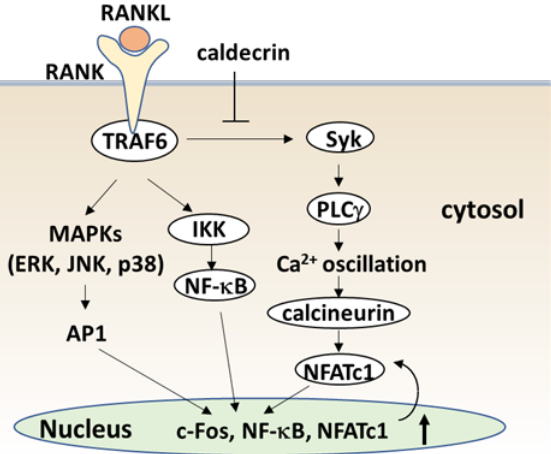
Figure 4. Caldecrin inhibits RANKL signaling in the initial stage of osteoclast differentiation. RANKL binding to RANK activates both NF - κB and MAPKs, such as ERK, JNK, and p38. Activation of NF- κB and MAPK signals is then transmitted to c -Fos and NFATc1 induction. Caldecrin inhibits RANK -stimulated phosphorylation of Syk and PLCγ , abolishing Ca 2+ oscillation and activation of calcineurin, and amplification of NFATc1 in the initial stage of osteoclast differentiation. AP-1: activator protein- 1; ERK: extracellular signal -regulated kinase; IKK: I κ B kinase; JNK: C-Jun N-terminal kinase; MAPK: mitogen-activated protein kinase; NFATc1, nuclear factor of activated T-cells cytoplasmic 1; NF- κB: nuclear factor - κB; PLCγ : phospholipase C γ; RANK: receptor activator of NF - κB; RANKL: RANK ligand; Syk: spleen tyrosine kinase; TRAF6: tumor necrosis factor receptor -associated factor 6.